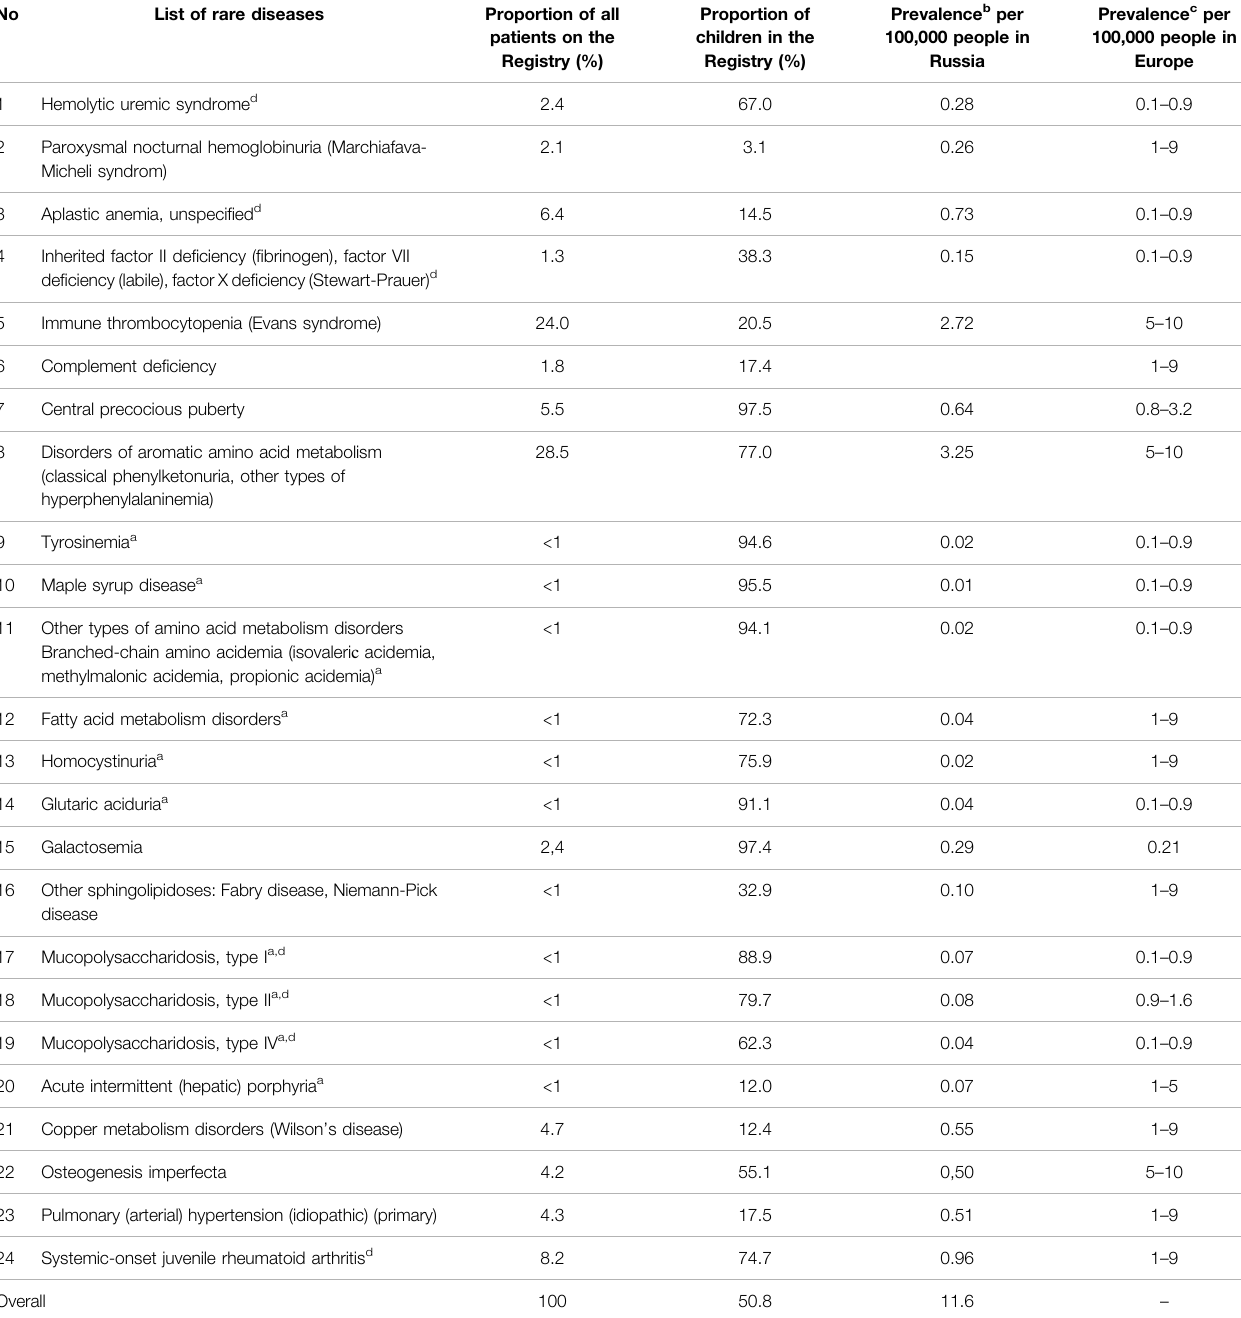
TABLE 4 | The distribution of patients from the “ The regional list of patients with rare diseases ” of the Registry as of January 1,